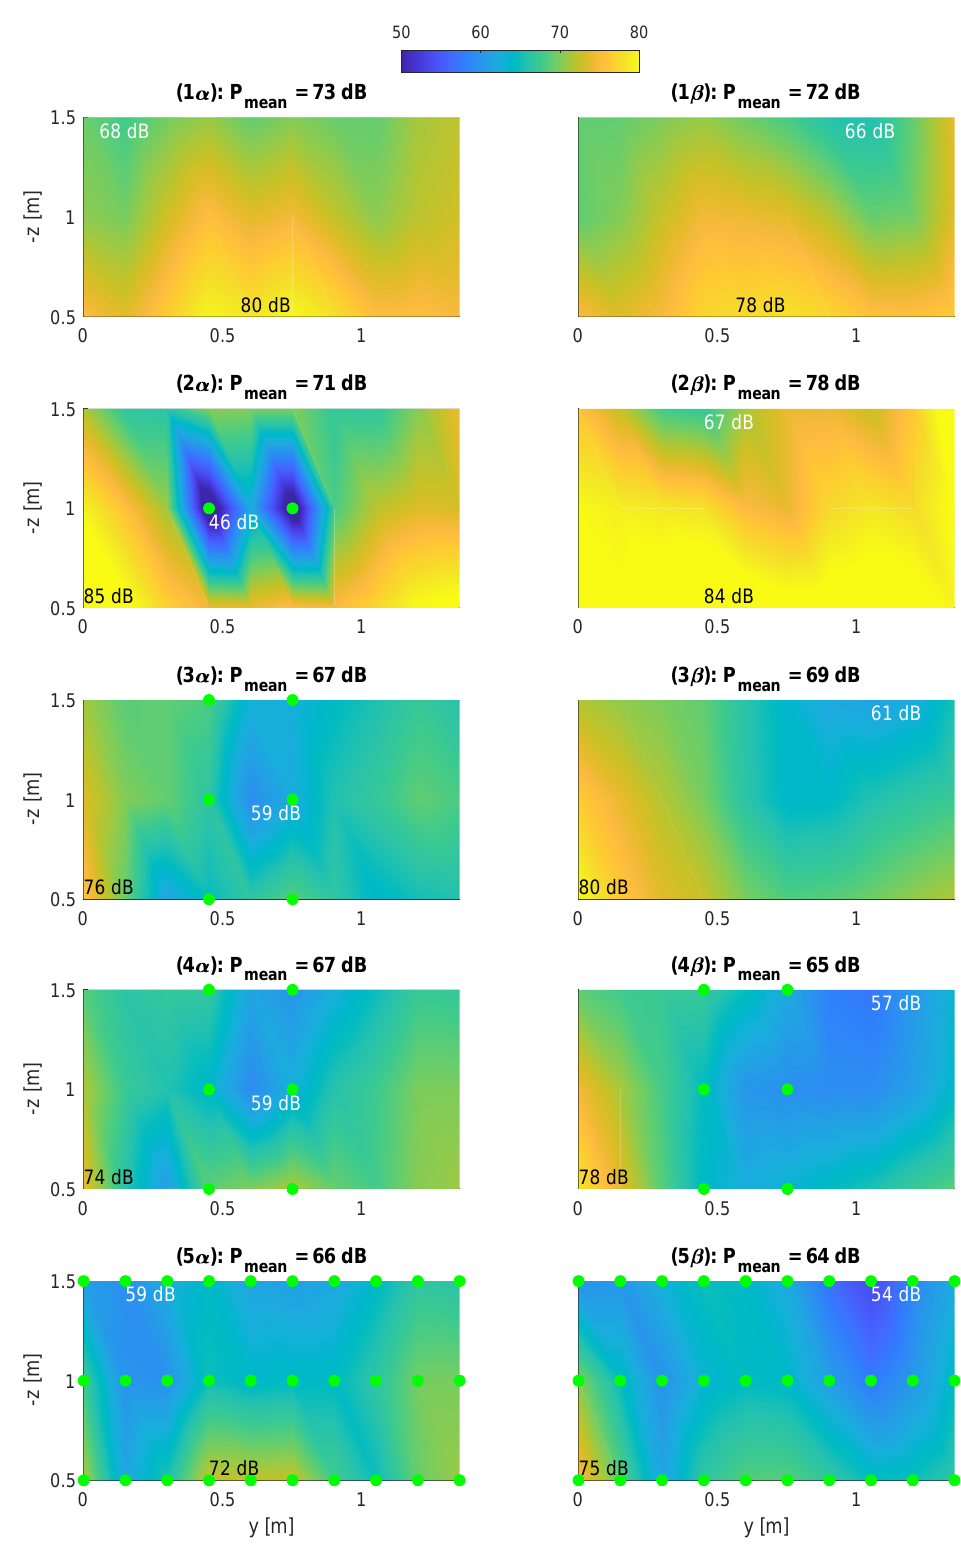
Figure 5. SPL distribution in front of the lining evaluated on two planes α and β . Four different virtual microphone configurations (2–5) are compared to the uncontrolled case (1). The maximum, minimum and mean SPL are provided for each plot. The locations of the virtual error microphones are indicated by a green